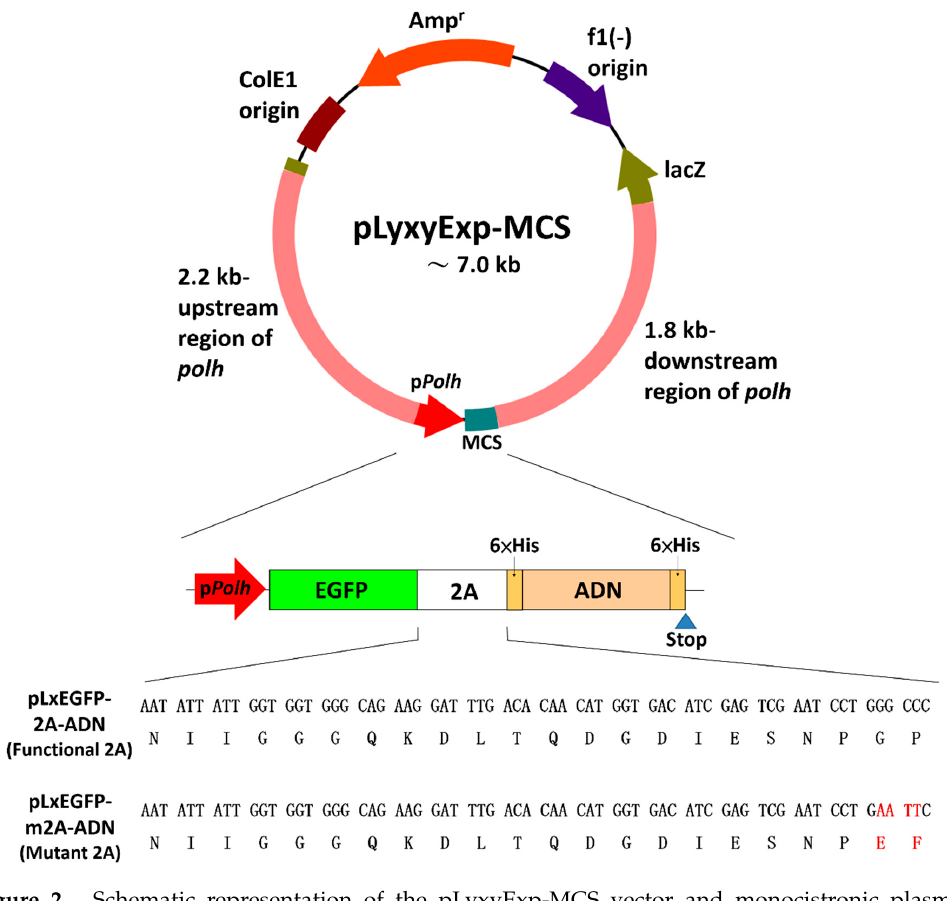
Figure 2. Schematic representation of the pLyxyExp-MCS vector and monocistronic plasmid construction for the co-expression of enhanced green fluorescent protein (EGFP) with porcine adiponectin (ADN) by the baculovirus LyxyMNPV. To test the function of the 2A linker, genes for EGFP and ADN were in-frame fused with the nucleotide sequences encoding either a functional 2A peptide (upper) or a nonfunctional m2A peptide (lower). The specific nucleotide and amino acid changes in m2A are shown in red. The constructs EGFP-2A-ADN and EGFP-m2A-ADN were